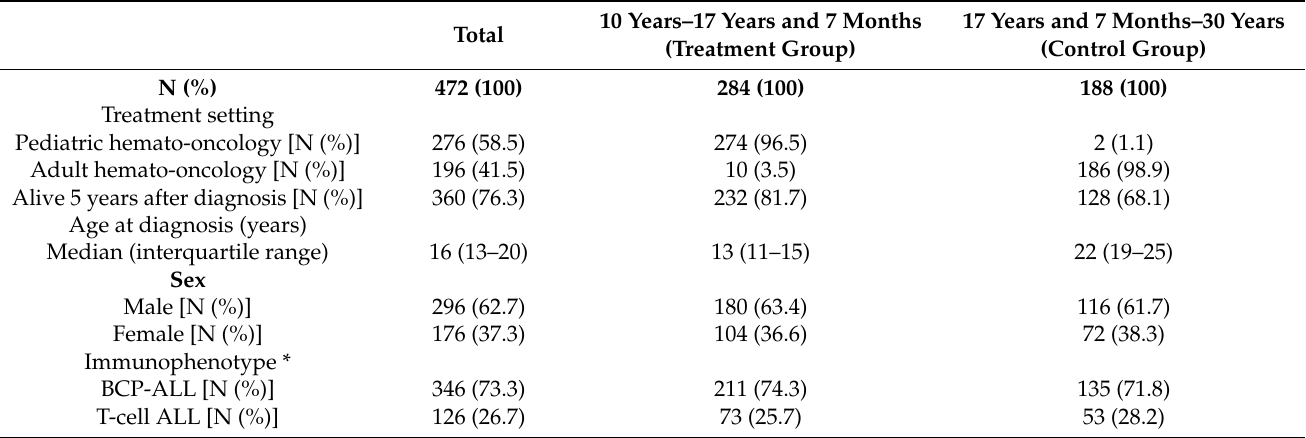
Table 1. Descriptive statistics of patients aged 10–30 years with acute lymphoblastic